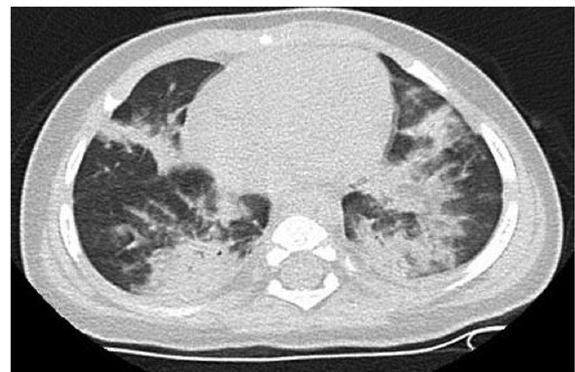
Figure 1. High-resolution computed tomography (HRCT) of an 11-month-old boy with epilepsy, hydrocephalus, cognitive/motor delay, sepsis, and COVID-19 pneumonia: Bilateral ground-glass opacities and areas of complete/incomplete consolidation containing sporadic air bronchograms in the basal segments and perihilar region that are more pronounced in the middle and lower zones of the lung parenchyma. COVID-19: coronavirus disease